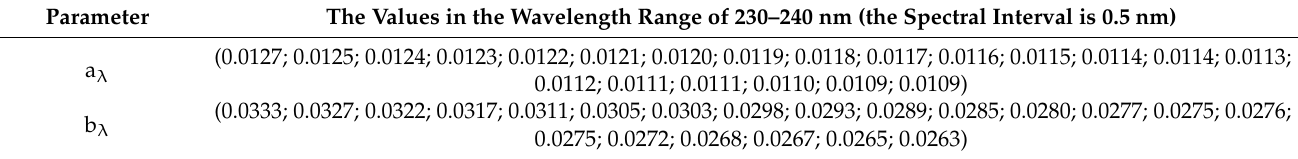
Table 1. Regression parameters in the wavelength range of 230–240 nm.